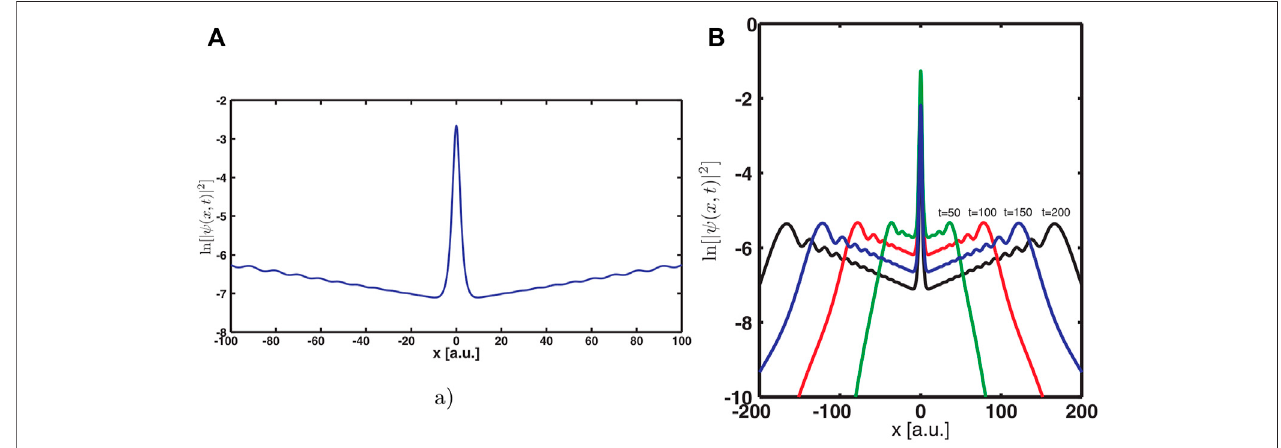
FIGURE 1 | (A) Illustration of the asymptotic divergence of the resonance state density for the model potential V ( x ) (cid:2) ( 1 − cosh − 2 ( x )) 2 exp (− 0 . 05 x 2 ) (B) The probability density of the wavepacket at different times on a logarithmic scale. Note that the region of exponential increase in the spatial domain is expanding with time. Reprinted from Ref. [3], Copyright (Year), with permission from